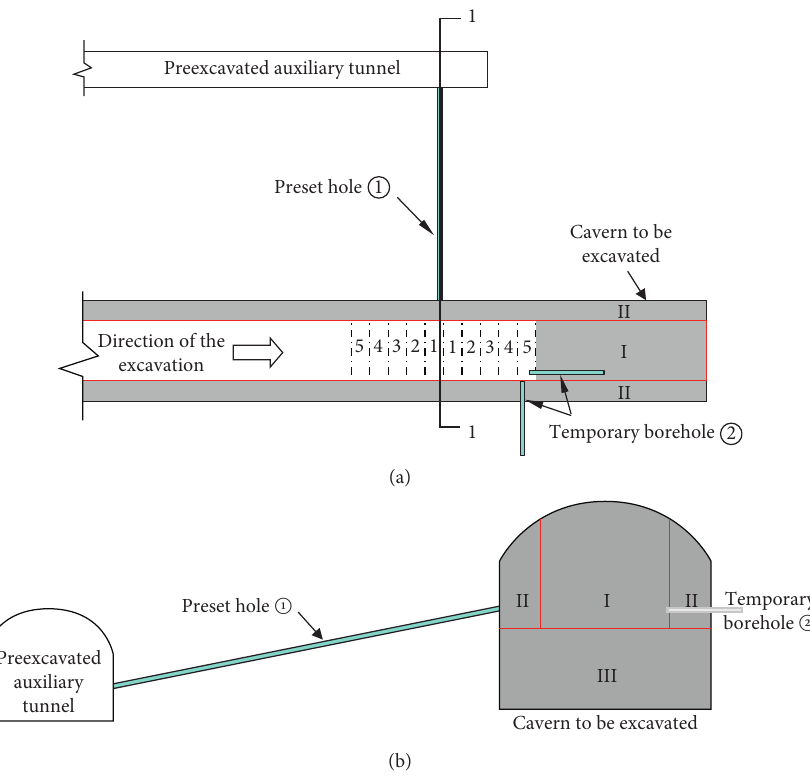
Figure 3: Layout of the test hole for acoustic testing. (a) Plane view and (b) section view of